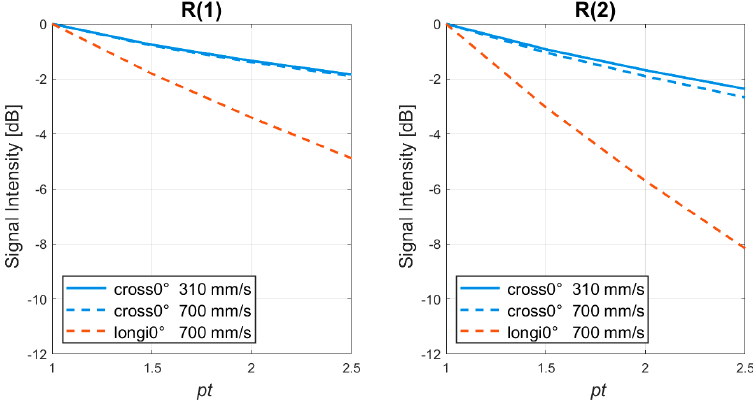
Figure 10. Simulated R(1) and R(2) signal intensity of the blood flow as a function of the pt value in TMAS power Doppler detection. The inclined angle of the flow vessel is 0°.